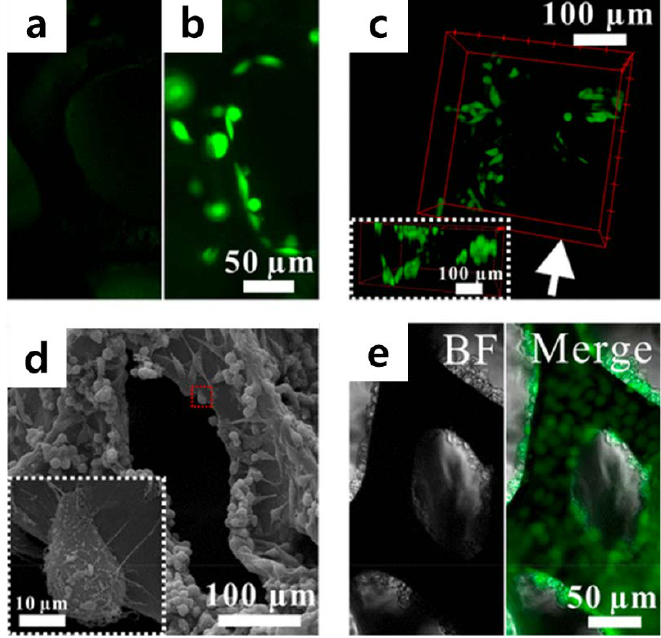
Figure 8. ( a ) Fluorescence images of GFP-HeLa cells cultured on ( a ) GF, ( b ) GF/ phenylboronic acid (PBA)/3-aminophenylboronic acid (APBA), and ( c ) GF/PBA/APBA composites. ( d ) SEM images of HeLa cells cultured on GF/PBA/APBA composites. The enlarged image of the red rectangle area is shown in a white square. ( e ) Microscopic images of HeLa cells cultured for 11 days. The bright field (BF) and the merger of the bright field and fluorescence field (Merge) images are presented. The reprint of this figure from [115] is permitted by the American Chemical Society.